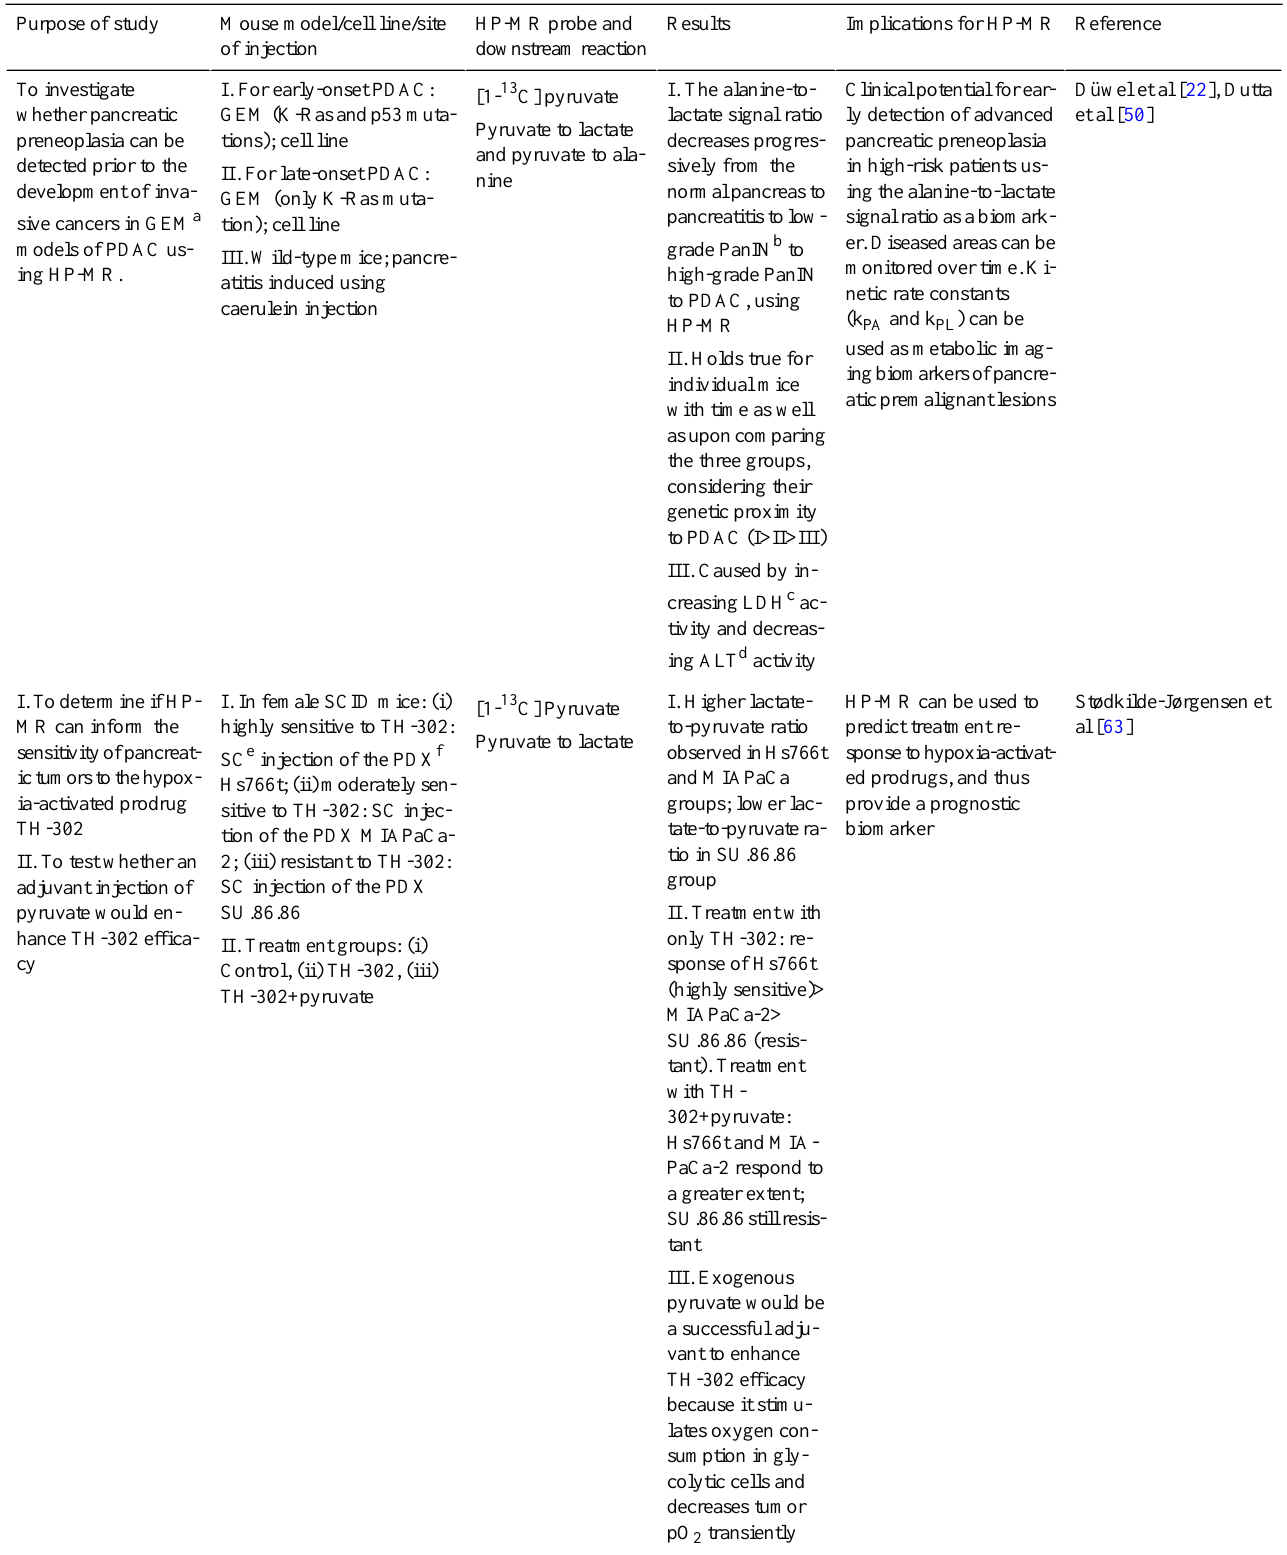
Table 2. Review of published applications of hyperpolarized magnetic resonance (HP-MR) in preclinical pancreatic ductal adenocarcinoma (PDAC)